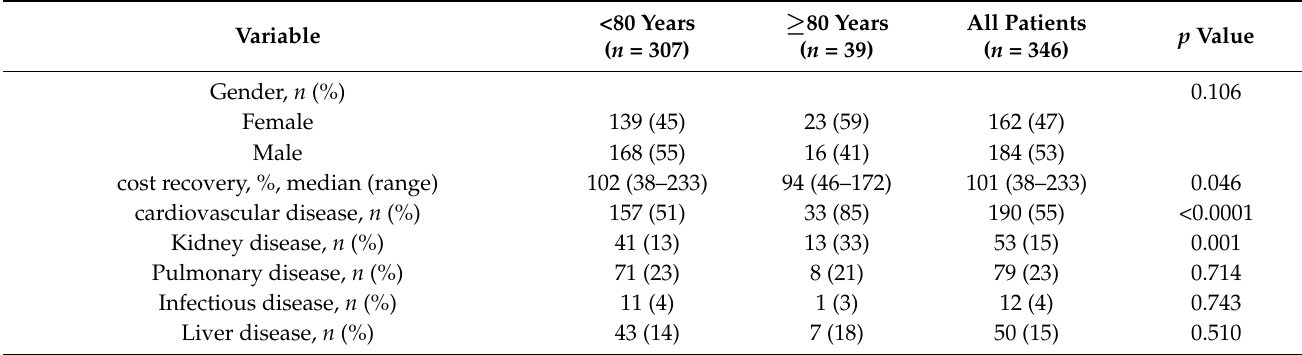
Table 1. Comparison of clinicopathological characteristics of 346 patients undergoing pancreatic surgery according to patient